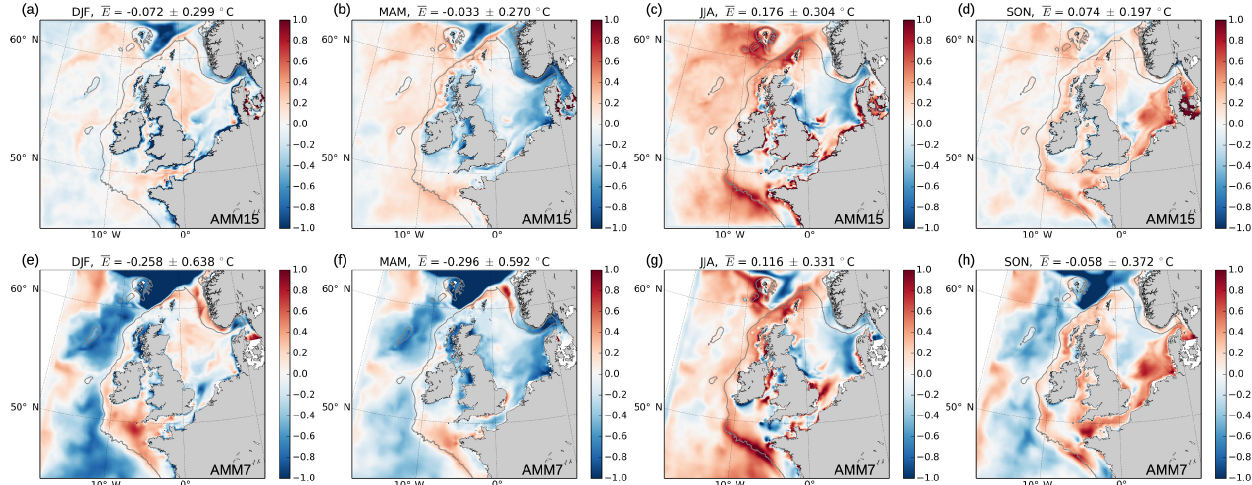
Figure 3. Seasonal SST anomalies for model minus observations ( ◦ C). Observations used are OSTIA CCI reanalysis product (Merchant et al., 2014; OSTIA CCI product only available from September 1991). All panels show 20-year mean anomalies for the period 1991– 2010, with anomalies calculated as SST AMM − SST OSTIA . Upper panels (a–d) show anomalies for AMM15-OSTIA, lower panels (e–h) show anomalies for AMM7-OSTIA. Mean errors ( E ) and standard deviations are calculated spatially for the region shown (excluding wider AMM7 domain). Grey contour shows the 200m isobath to indicate the limit of the continental